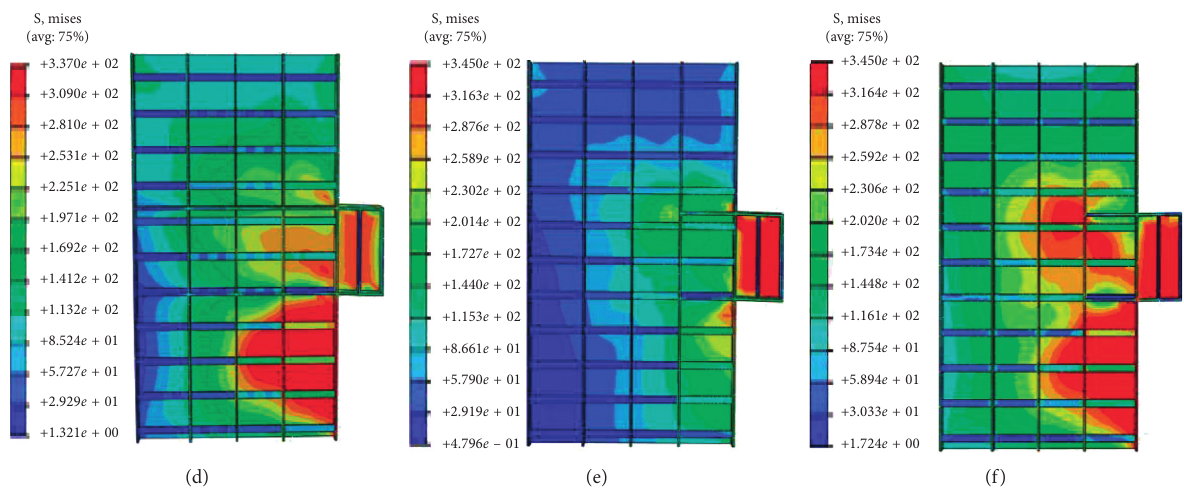
Figure 11: Stress responses of the steel at 4 Δ y . (a) PEC-1. (b) PEC-2. (c) PEC-3. (d) PEC-4. (e) PEC-5. (f) PEC-6.